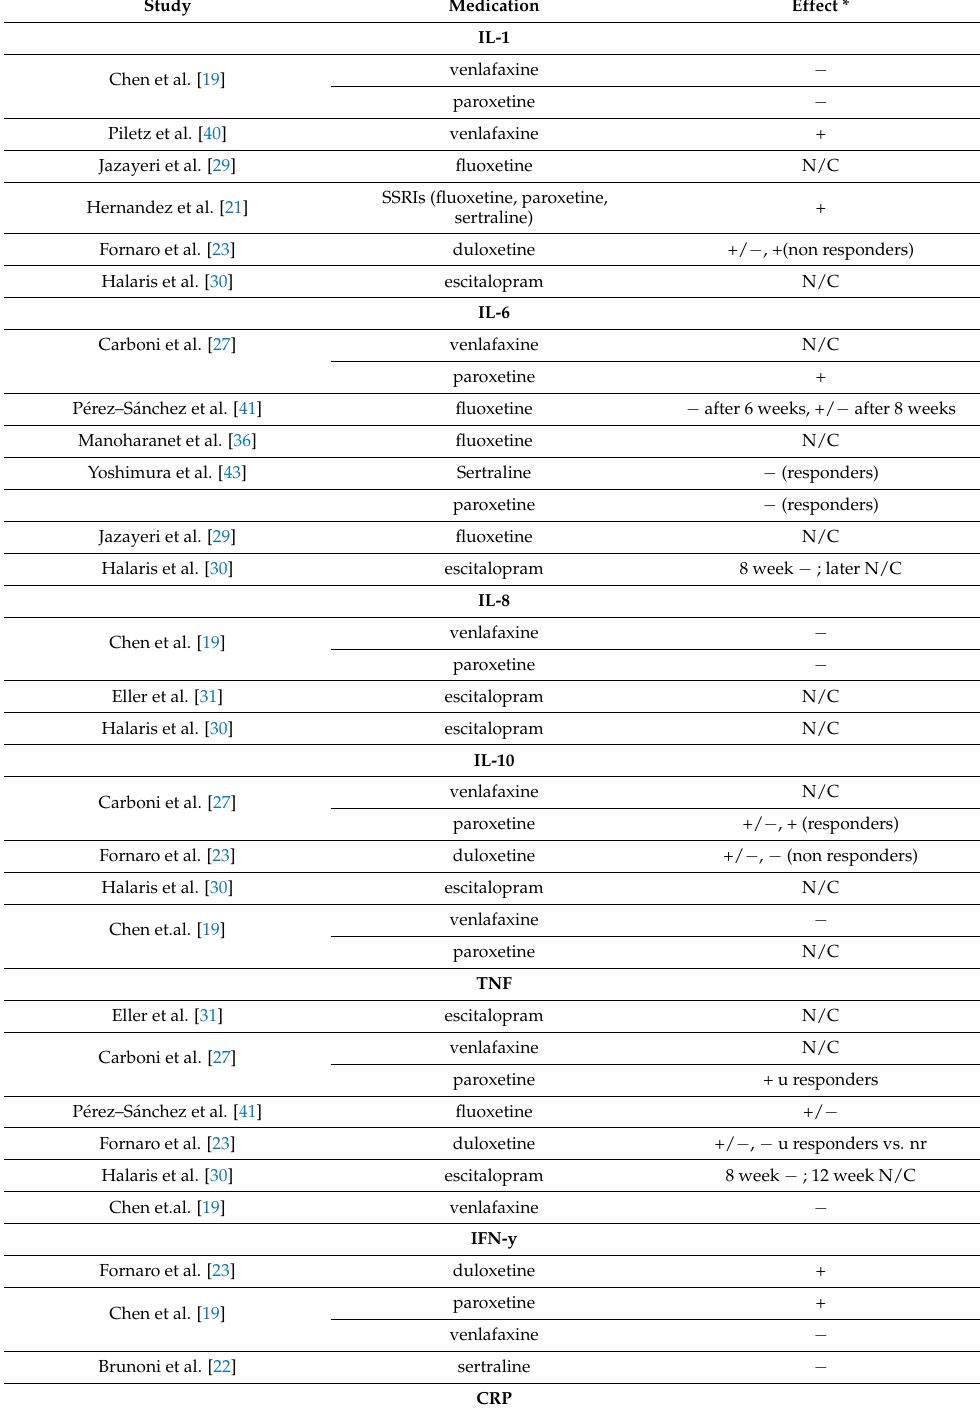
Table 2. The effects of antidepressant drugs on various